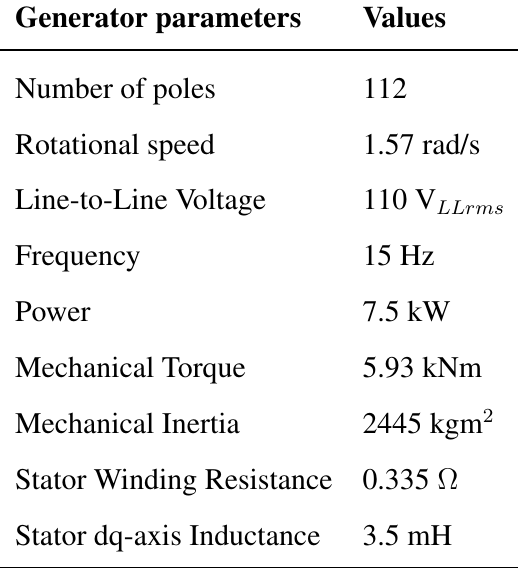
Table 1. Nominal generator